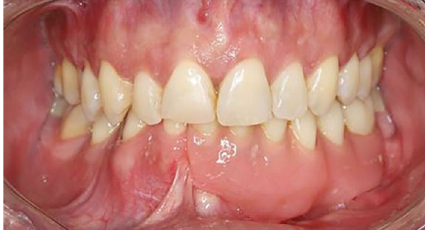
Figure 11: Clinical appearance after 9 years postsurgery and 7 years after implanto-prosthodontic